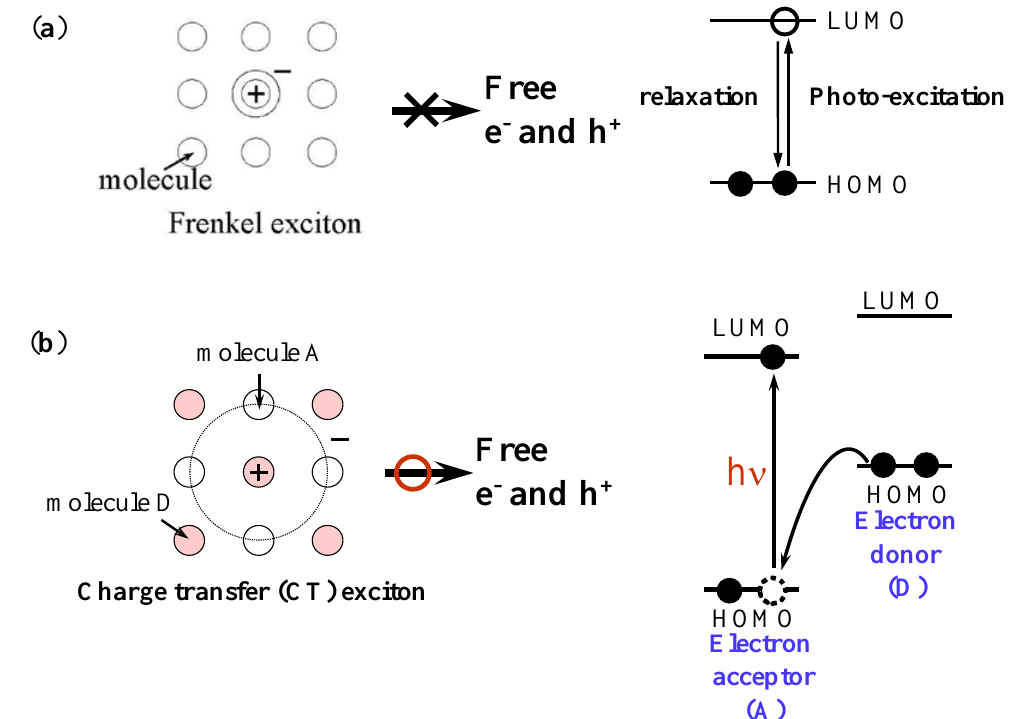
Figure 2. Carrier generation in organic semiconductors. ( a ) Single molecular solids; ( b ) Donor (D)/acceptor (A) sensitization of carrier generation by the mixing of two kinds of organic semiconductor molecules. Efficient free carrier generation occurs from the charge transfer (CT)